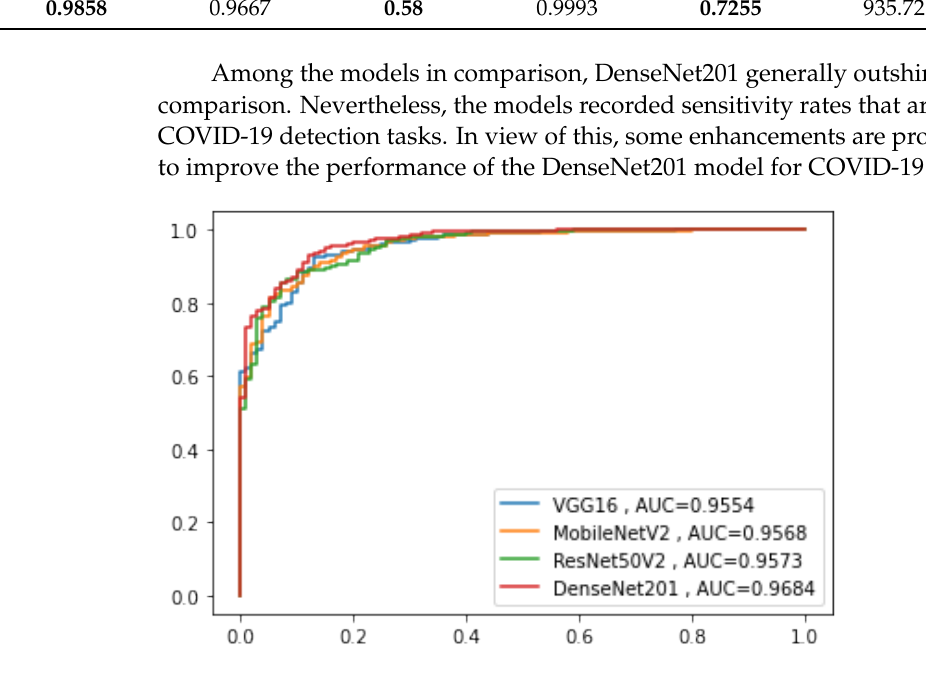
Figure 4. The receiver operating characteristics curve of the pre-trained